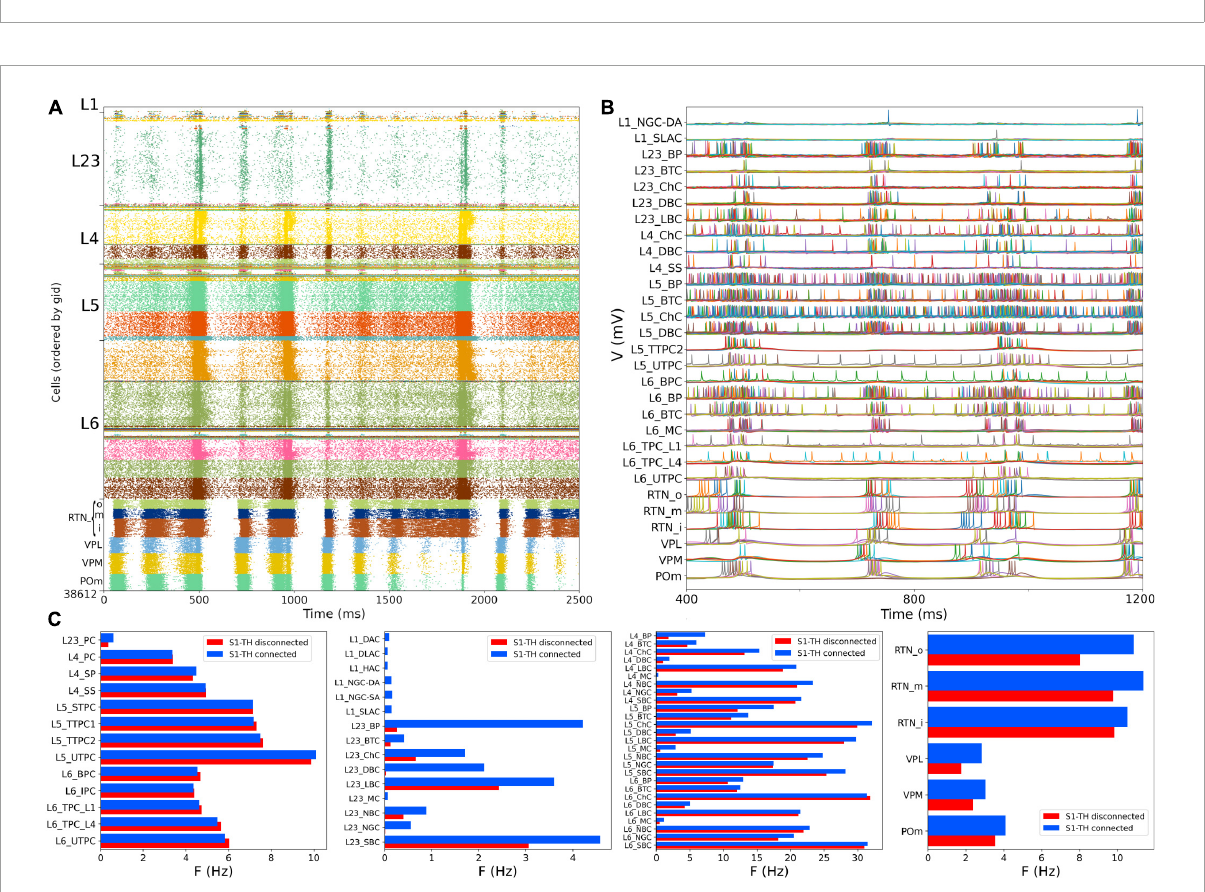
FIGURE7 NetPyNE S1 and thalamic circuit response with bidirectional thalamic connectivity and cortical STP. (A) Spiking raster plot of the fully connected circuit model, including bidirectional connections between S1 and thalamus (shows 2.5 s of simulation after steady state was reached). Oscillations at ∼ 6 Hz were now synchronized across all S1 and thalamic populations. (B) Example traces from (A) during 800 ms showing spike synchrony across cortical and thalamic populations. (C) Comparison of mean firing rates of each of the 55 S1 and 6 thalamic m-types with ( S1-TH connecte d) and without ( S1-TH disconnected ) bidirectional thalamocortical connectivity (compare rasters in panel A and Figure 6A ,